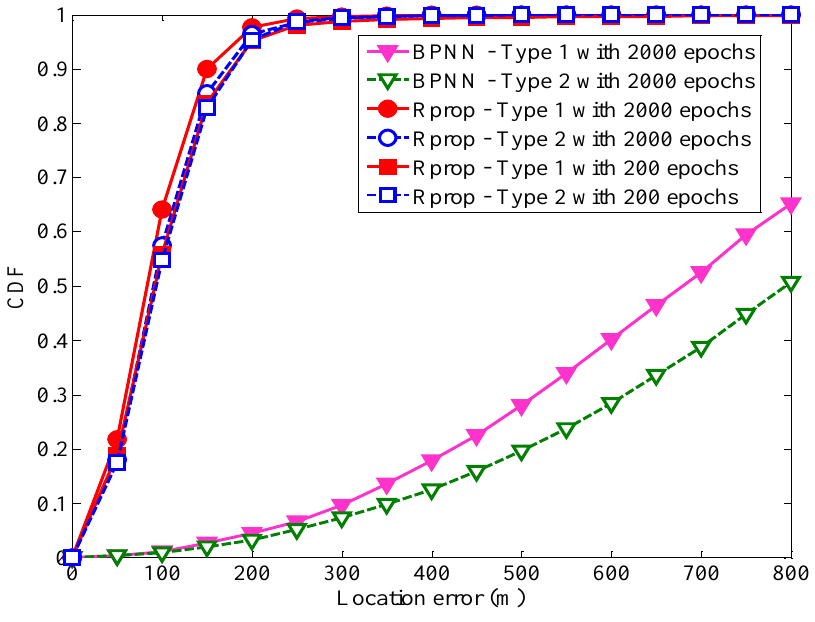
Figure 7. Comparison of average MS location based on BPNN and Rprop.